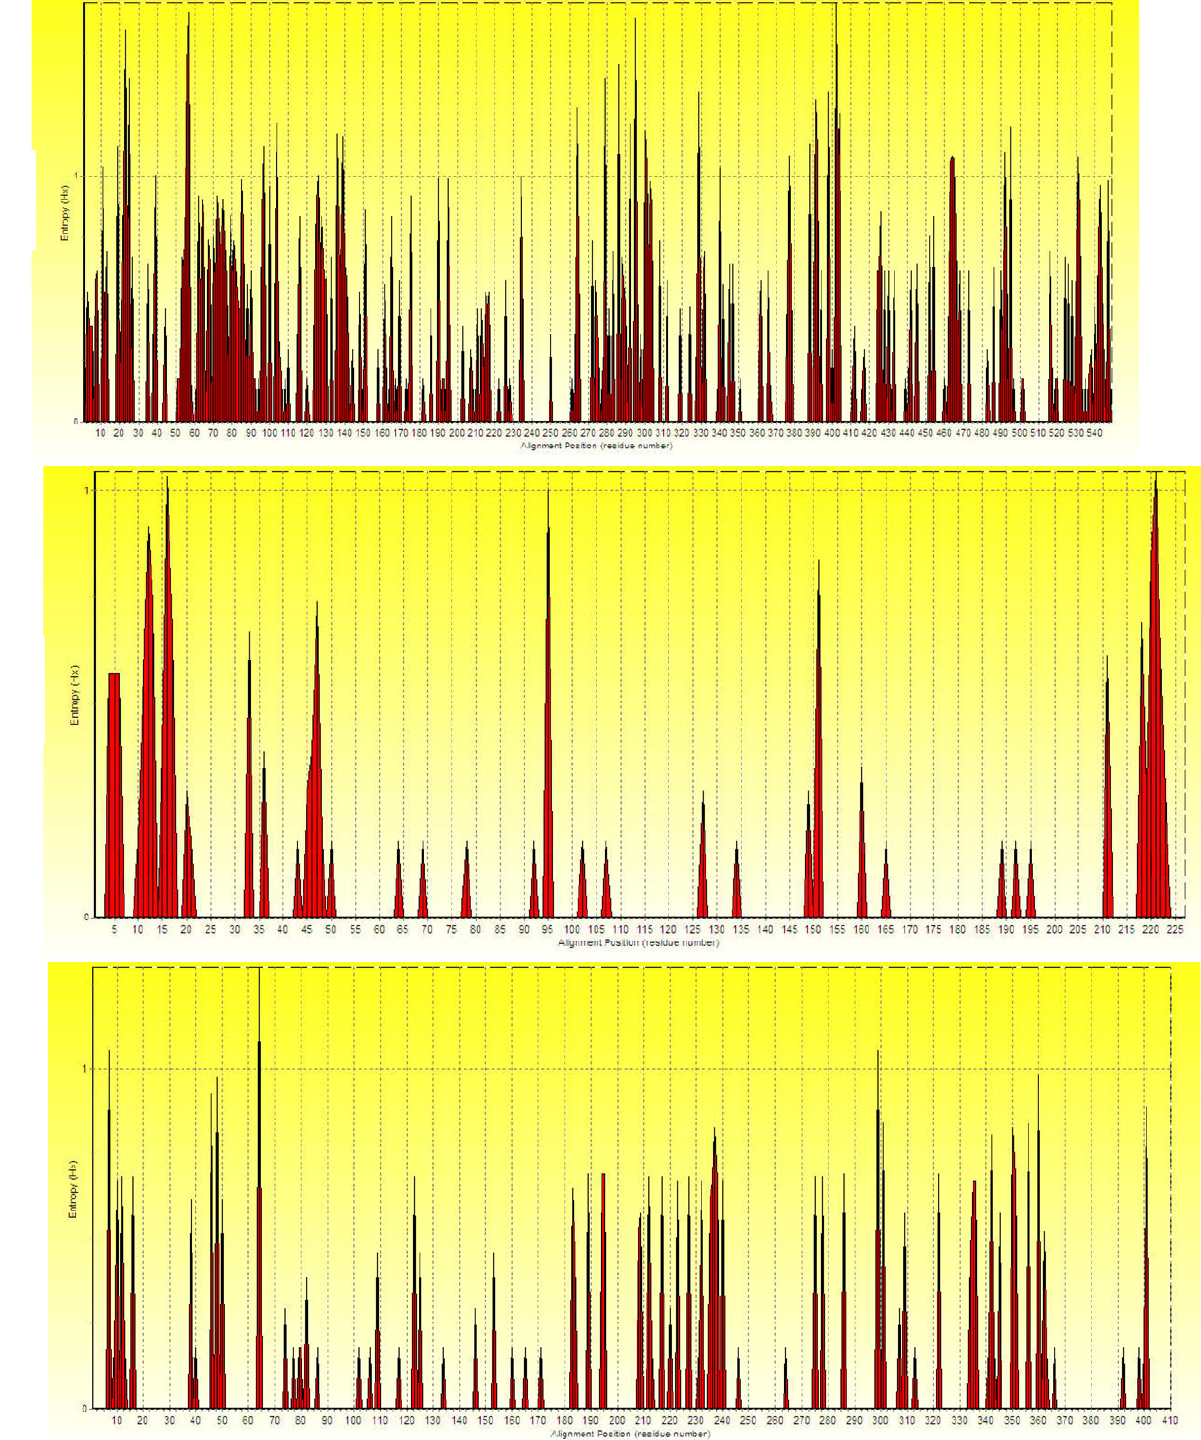
Figure 2. Entropy plot of amino acid of ( a ) S1, ( b ) M and ( c ) N protein gene of IBV. X-axis gives the amino acid sites of S1, M and N gene; y-axis gives the entropy of each amino acid